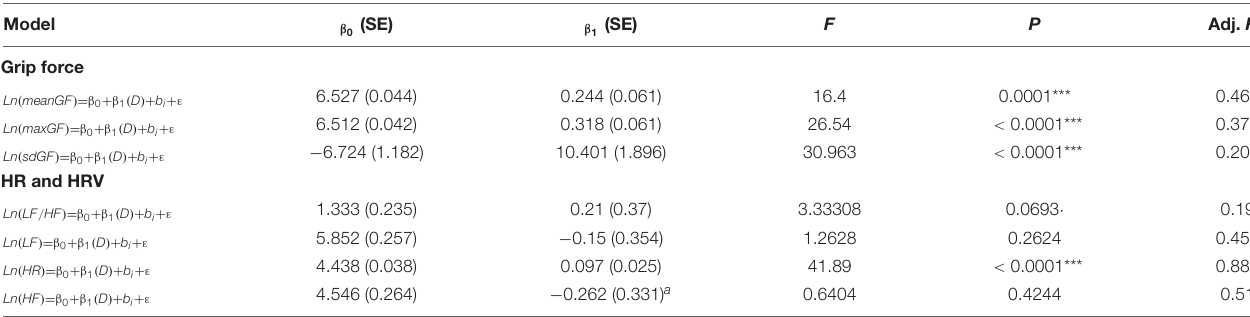
TABLE 1 | Summary of linear mixed model analyses for various models.